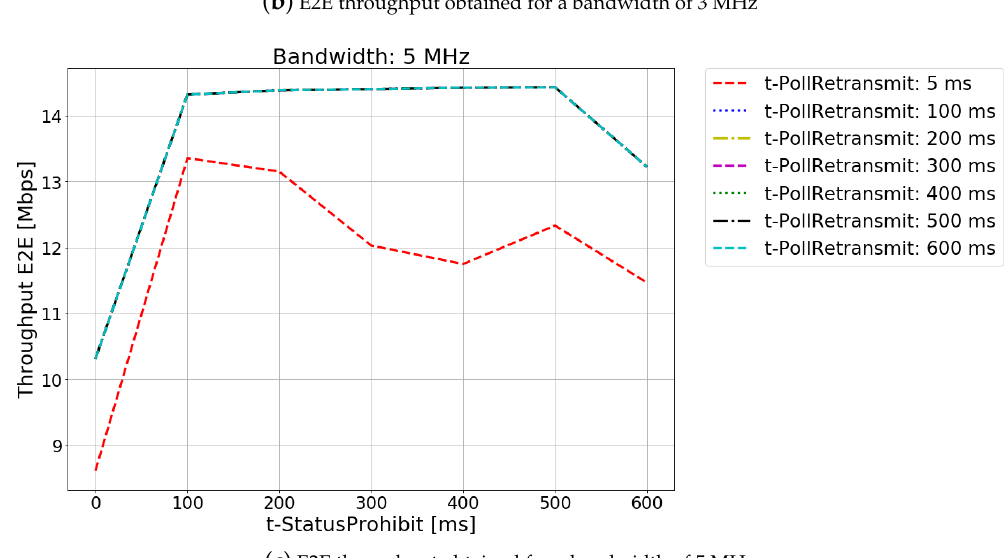
Figure 2. End-to-end (E2E) throughput